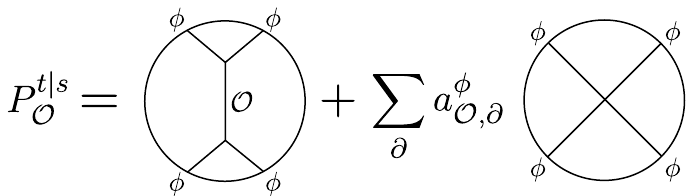
Figure 3. The t -channel Polyakov Regge block is a t -channel exchange Witten diagrams plus a finite sum of quartic, contact